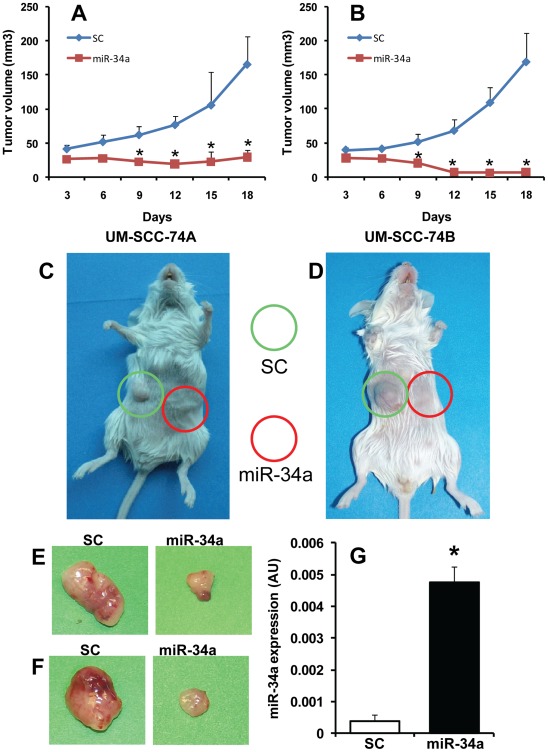
miR-34a inhibits tumor growth in vivo.Tumor cells transfected with miR-34a or SC were mixed with 100 µl of Matrigel and injected subcutaneously in the left and right flanks of SCID mice respectively (n = 5). Tumor volume measurements began on day 3 and continued twice a week until the end of the study. The length and width of the tumors were measured using a digital caliper and tumor volumes were calculated using the formula, volume (mm3) = L×W2/2 (length L, mm; width W, mm). After 18 days, tumors samples were carefully removed. A-B: Tumor growth curves for UM-SCC-74A and UM-SCC-74B respectively. *, represent a significant inhibition (p<0.05) of tumor growth in miR-34a group cells as compared to SC. C-D: Representative photographs of mice bearing UM-SCC-74A or UM-SCC-74B tumors. Green and red circles are used to highlights tumor cells transfected with scrambled control (SC) or miR-34a, respectively. E-F: Representative photographs for UM-SCC-74A and UM-SCC-74B tumors at day 18, respectively. G: miR-34a levels in UM-SCC-74A tumors at the end of the in vivo experiments. *, represent a significant difference (p<0.05).